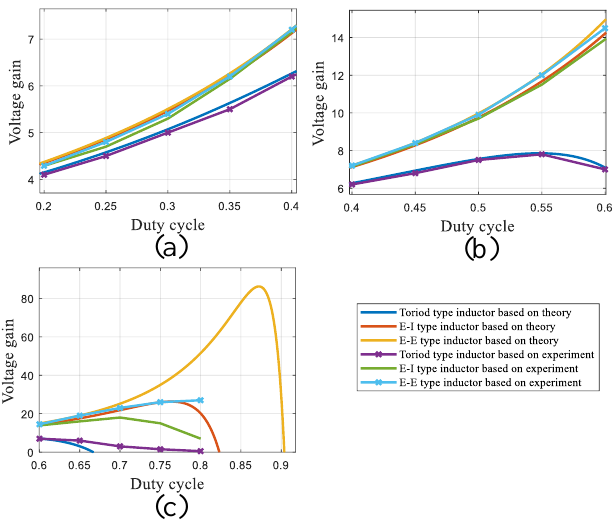
Figure 19. The voltage gain comparison based on the theory and experimental results of the toroid type, E–E type, and E–I type of the inductor cores while the duty cycle varies from ( a ) 0 to 33%, ( b ) 33% to 66%, and ( c ) 66% to 100%.